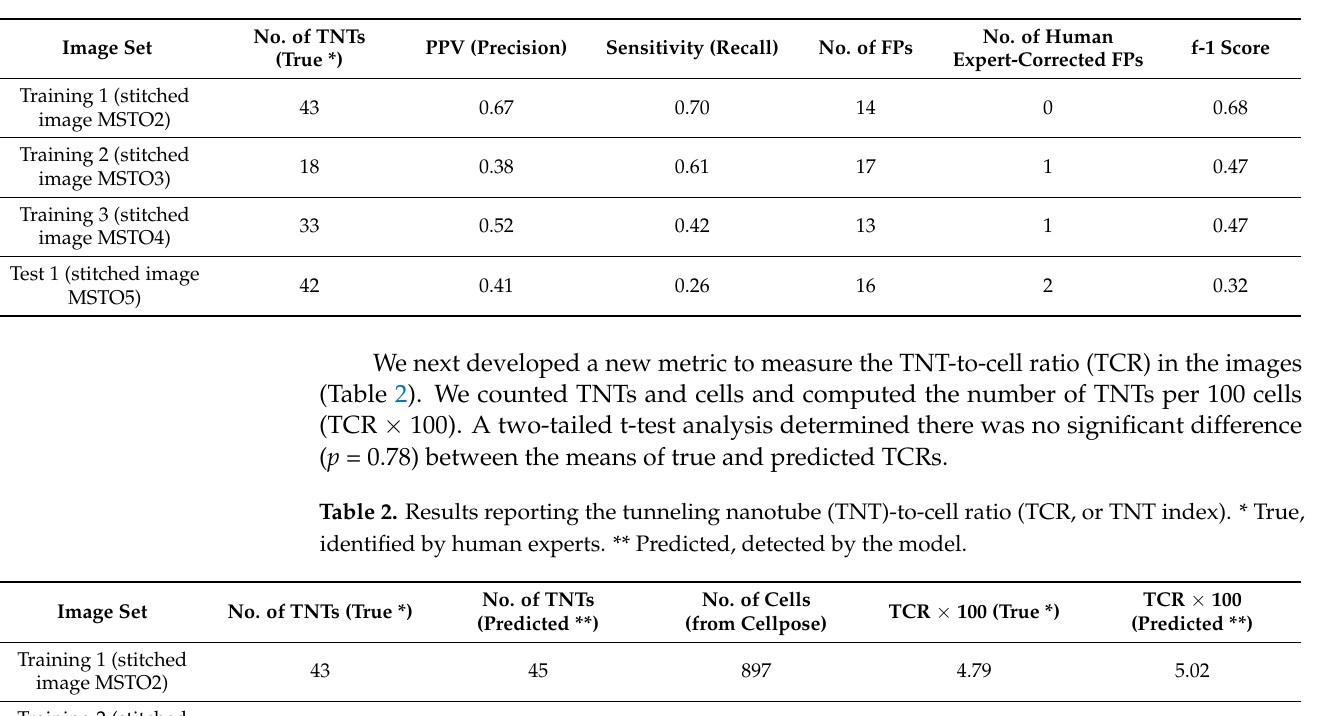
Table 1. Results of TNT detection for three training sets and one test set. FP = false positive, PPV = positive predictive value. * True, identified by human experts. f-1 score = 2 × [PPV × sensitivity]/ [PPV + sensitivity].